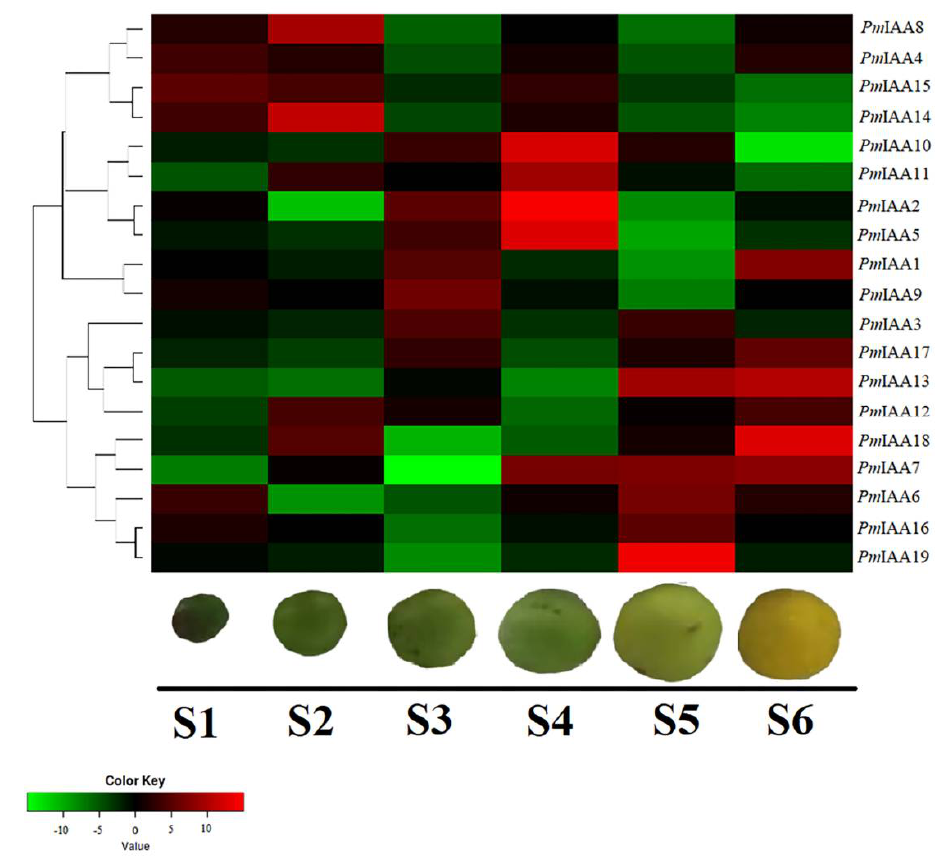
Figure 8. Expression profiles (hierarchical clustering) of PmIAA genes during different stages of fruit development and ripening. Color key shows the expression as red (up-regulated) and green (down-regulated) of the genes. Stages (S1–S6) and the fruit sample are shown under the Heatmap.